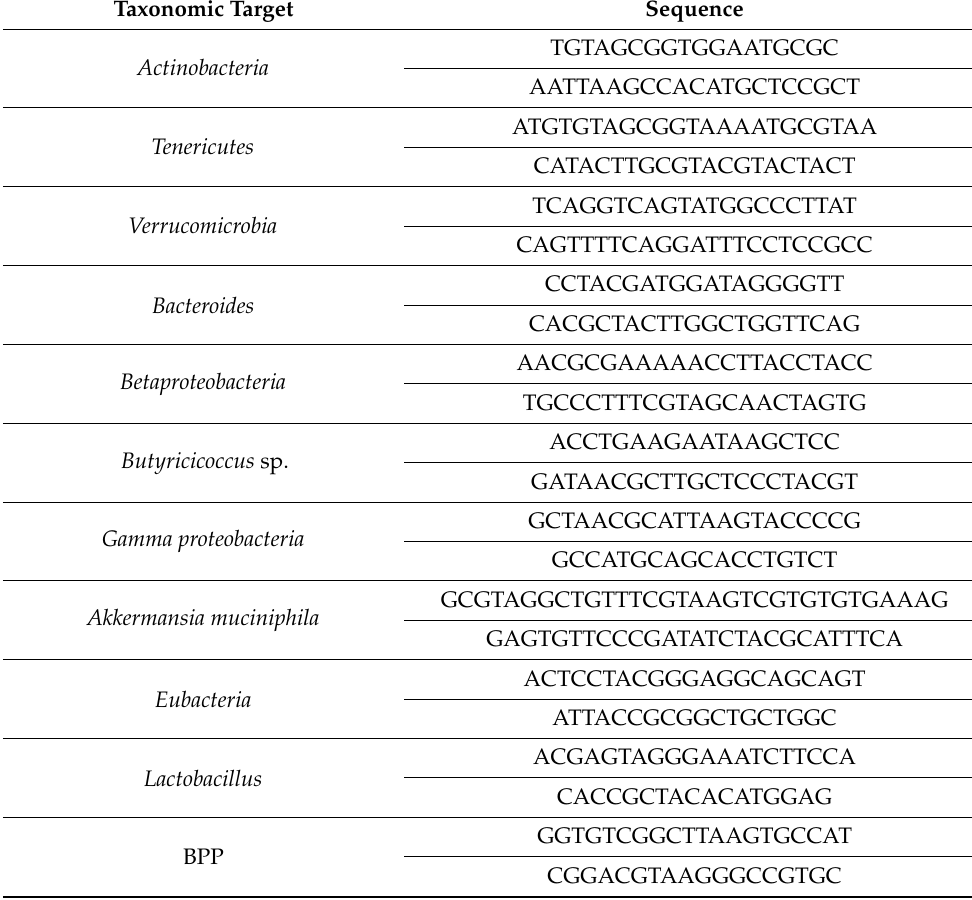
Table 2. Primers used within this